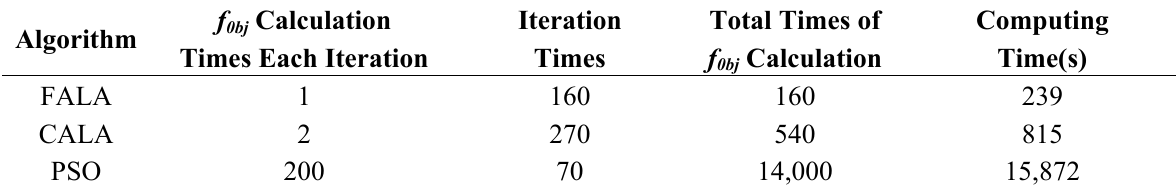
Table 2. Algorithm complexity and computing